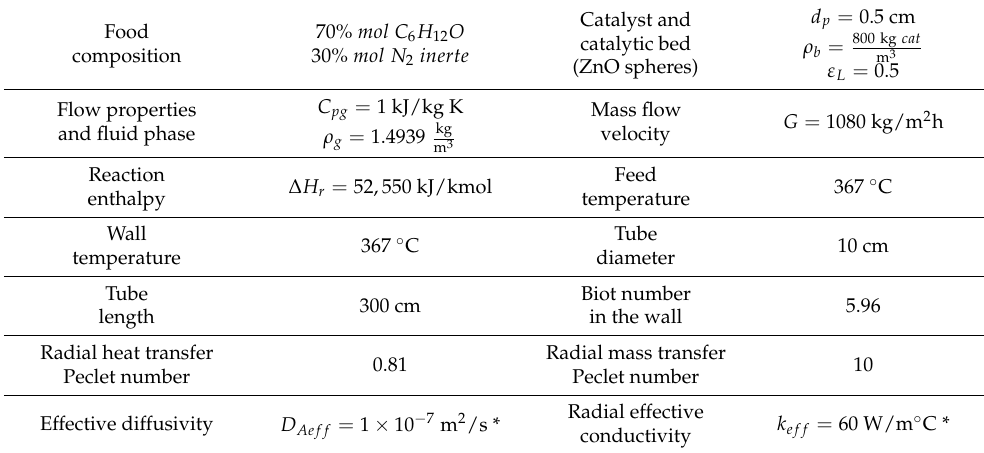
Table 1. Data of the cyclohexanol dehydrogenation process.